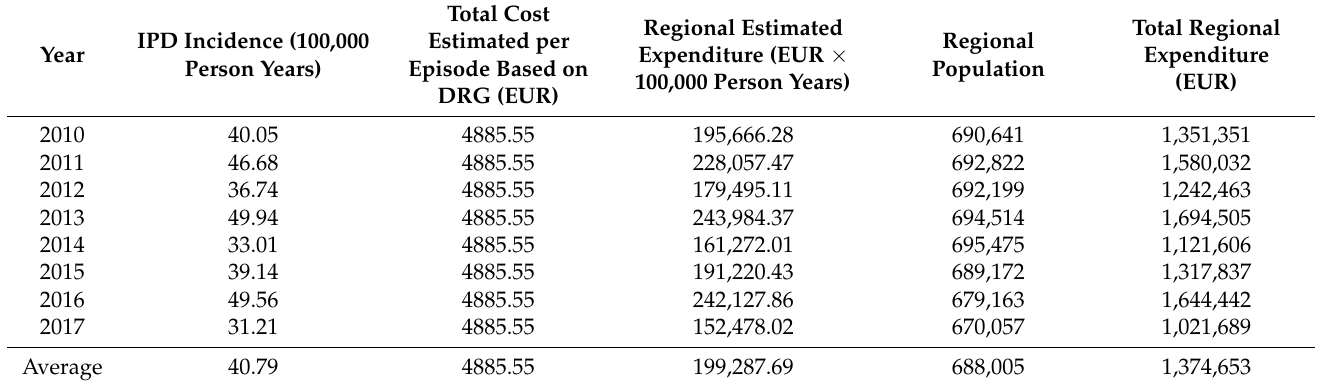
Table 7. Costs related to IPD and syndromic invasive